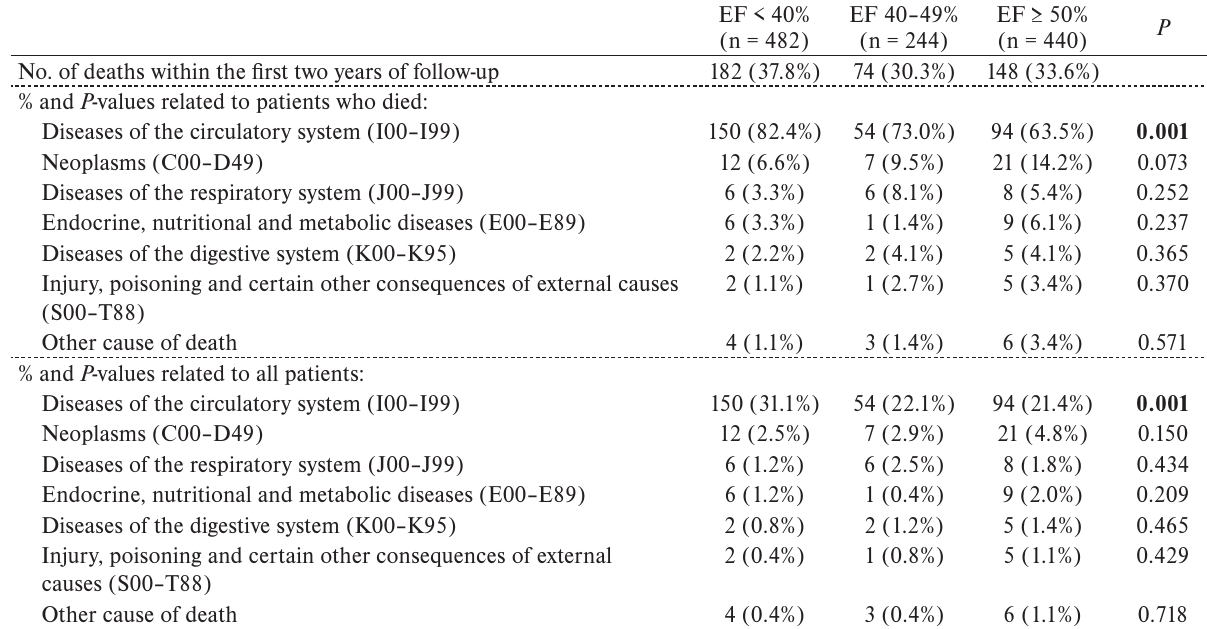
Table 6. Causes of death by LVEF, as reported in hospitalization records or in the Institute of Health Information and Statistics of the Czech Republic.